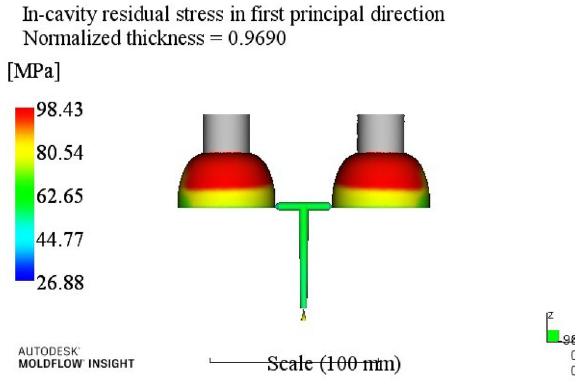
Figure 6. The first direction residual stress optimization results.